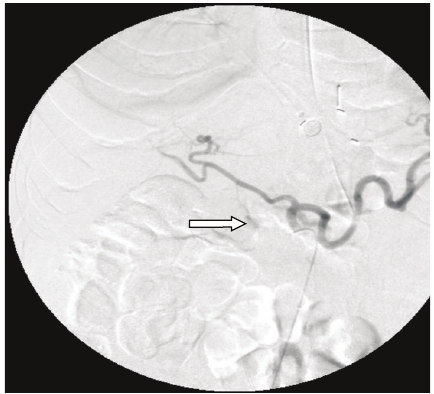
Figure 3: X-ray angiogram of the abdomen revealed pseudoa- neurysms in the distal gastroduodenal